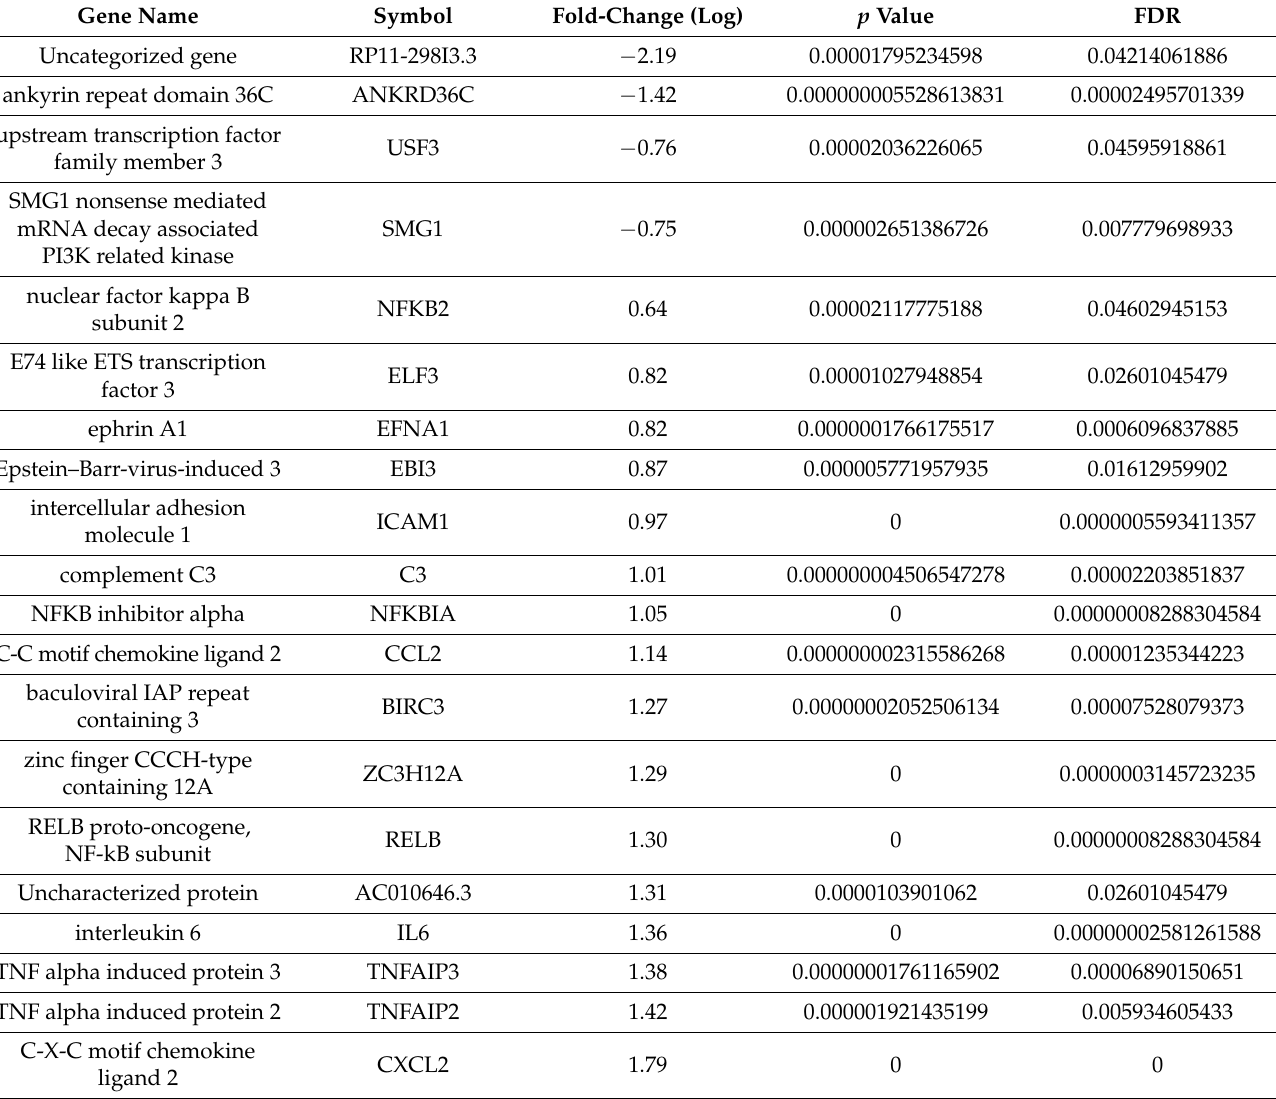
Table 1. Differentially expressed genes after 24 h of HBMEC exposure to MOI